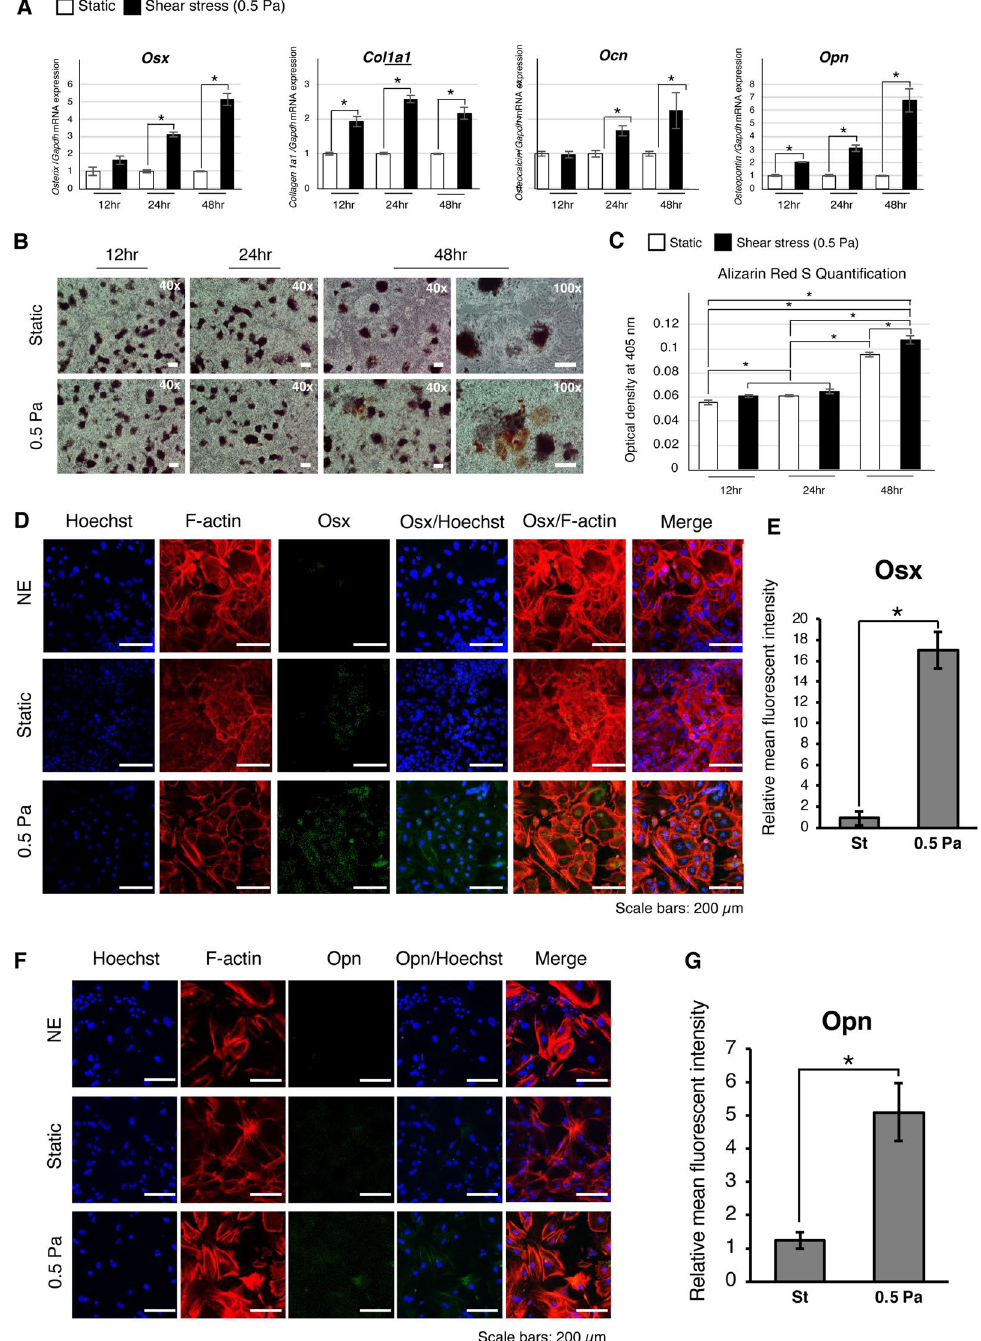
Figure 3. Continuous shear stress enhanced the osteogenic differentiation of iPSCs in a time-dependent manner. Evaluation of osteogenic differentiation under 0.5 Pa; iPSCs were maintained in OS medium for one day prior to the application of 0.5 Pa of shear stress for 12, 24, and 48 h, respectively. The control static culture in OS medium was collected at the same time point for evaluation ( A ) Relative gene expression of osteogenic markers ( Osx , Col1a1 , Ocn , and Opn ) was performed by Real-time RT-PCR. *: P < 0.05, Student’s t -test. Representative data from three independent experiments are shown (mean values ± SD: n = 3) ( B ) Alizarin Red S staining (red) was performed. The magnifications of upper and lower panels are 40 × and 100x, respectively. Scale bars: 200 μm. ( C ) Quantification of Alizarin Red S staining to evaluate mineralization level. *: P < 0.05, ANOVA with Tukey’s multiple comparison test. Representative data from three independent experiments are shown (mean values ± SD: n = 3). Immunofluorescence staining was performed to detect the nuclear localization of ( D ) Osx (green) and the expression of ( F ) Opn (green). Normal mouse IgG was used as negative control (NC). The cytoskeleton (F-actin; red) and nuclei (blue) were stained with rhodamine-phalloidin and Hoechst, respectively. Scale bars: 200 μm. The relative mean fluorescence intensity of ( E ) Osx and ( G ) Opn was quantified by ImageJ software. *: P < 0.05, Student’s t -test. Data represent the mean ± SD (n =